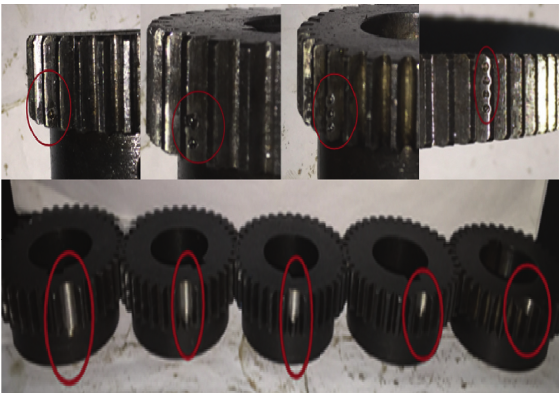
Figure 17: Fault gears (pitting and broken tooth).